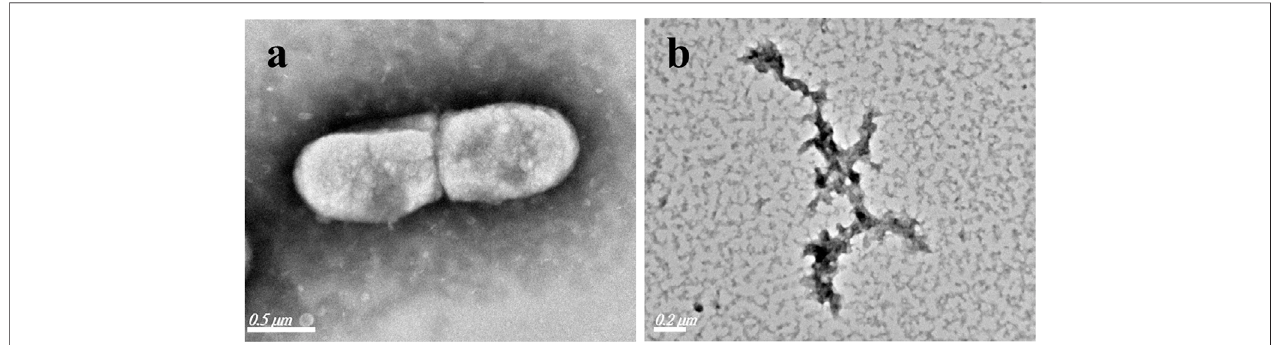
FIGURE 6 | TEM images of E. coli before (A) / after (B) treatment with LCPs